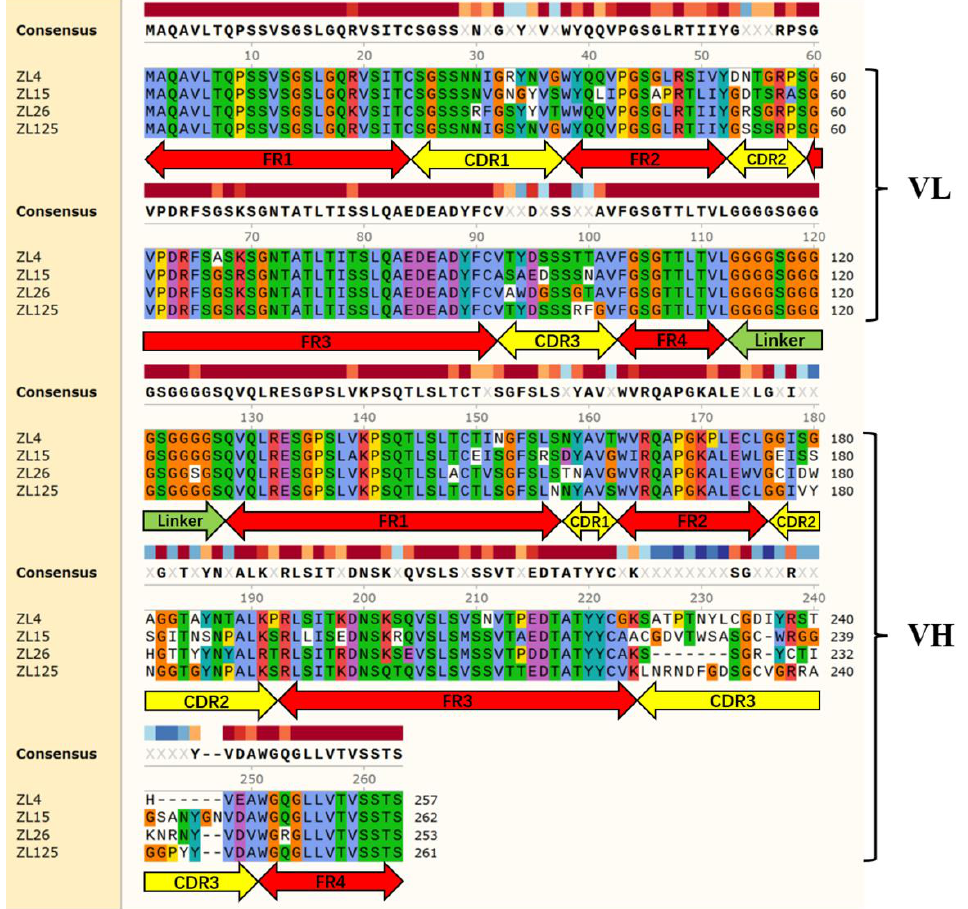
Figure 2. Align multiple protein sequences of ZL4, ZL15, ZL26, and ZL125. Four FRs and three CDRs for both VH and VL of each scFv are illustrated above. Same color regions represent identity of amino acids, while color blank regions represent amino acid differences of four scFvs.